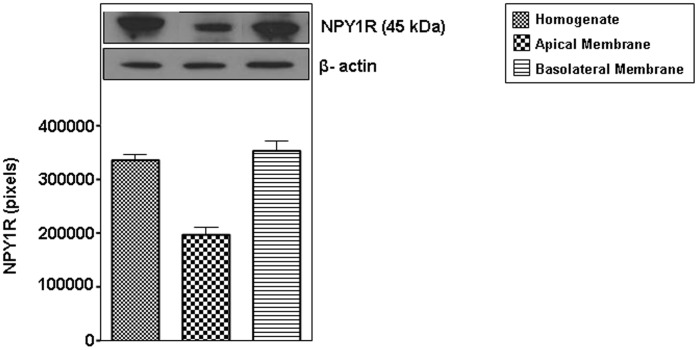
Detection of Y1 receptor (NPY1R) in Caco-2/15 cells in culture.Following differentiation, Caco-2/15 cells were homogenized and apical and basolateral membranes were isolated. Aliquots were fractionated by SDS-PAGE and electrotransferred onto nitrocellulose membranes. The blots were then incubated with the polyclonal antibody overnight at 4°C. Immunocomplexes were revealed by means of horseradish peroxidase-conjugated goat anti-rabbit immunoglobulin and an enhanced chemiluminescence kit. Y1 receptor mass was quantitated by use of an HP Scanjet scanner equipped with a transparency adapter and software. Values are expressed as means ± SD for n = 3 separate experiments in each group.